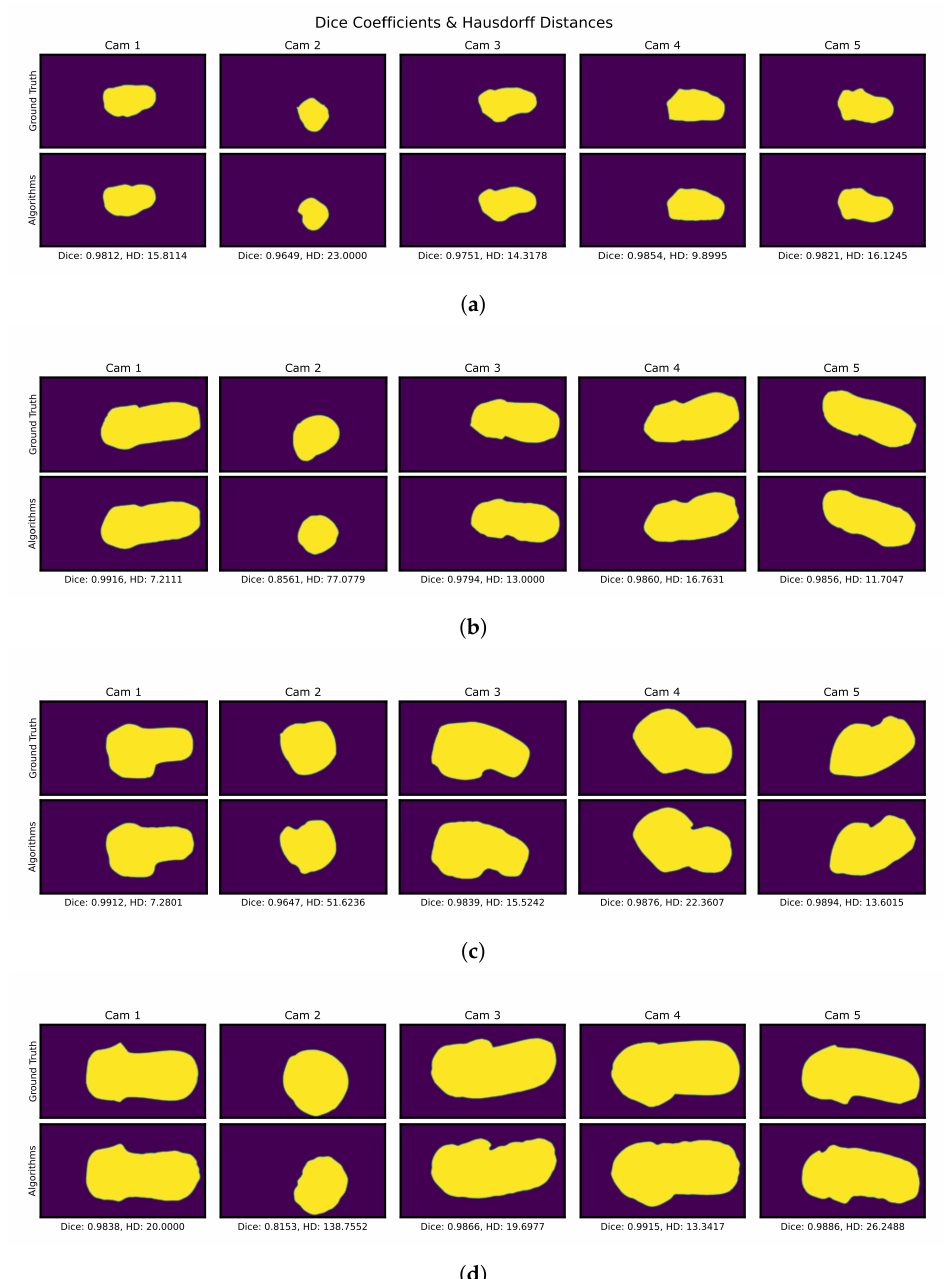
Figure 10. DC and HD metrics for RGB-based binary image segmentation for four scanned models. In each model, the top row displays the segmented object using manual segmentation as ground truth. Below are shown the segmentation results using the algorithms, which demonstrates a strong visual comparison. ( a ) M1. ( b ) M2. ( c ) M3. ( d )